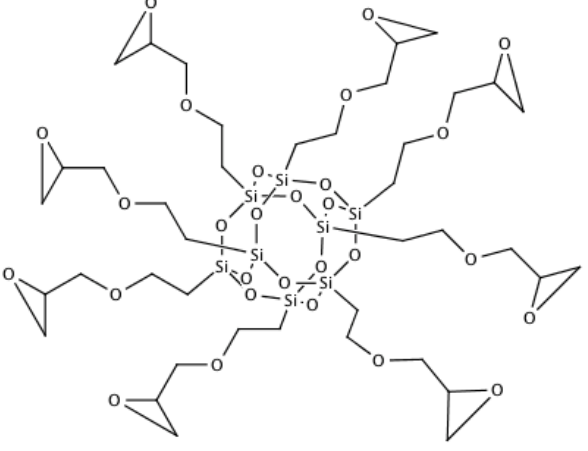
Figure 1. Molecular structure of glycidyl